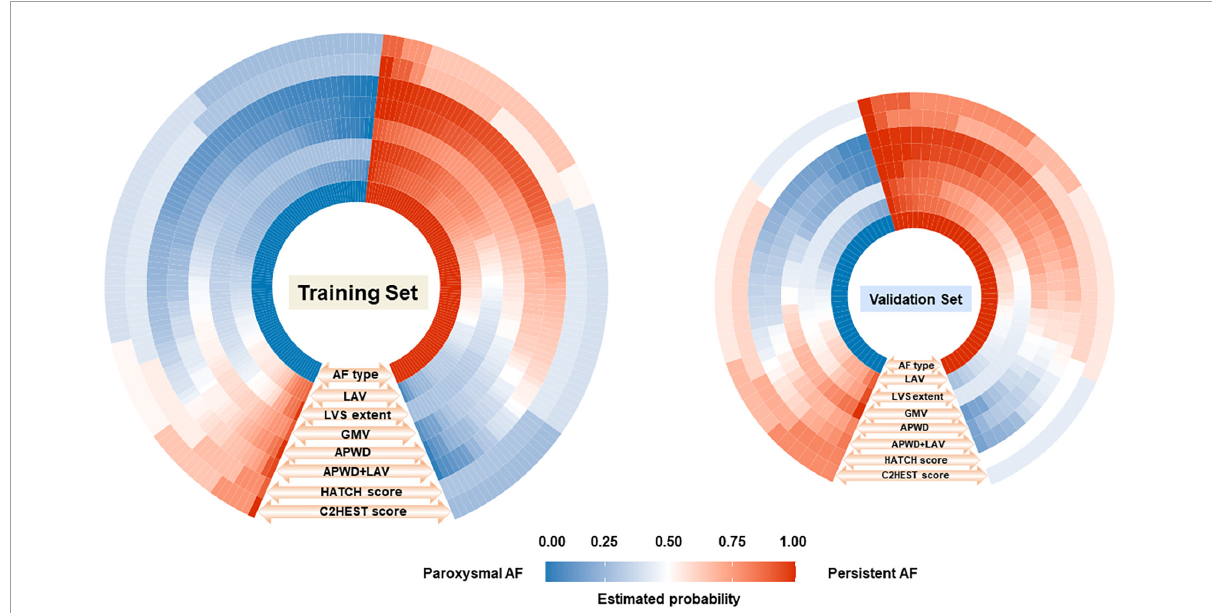
FIGURE5 Comparison between the estimated probability for persistent AF by each model (seven outer layers) and the actual AF types (inner layer, ground truth) in training (left) and validation (right) sets. The figure consists of eight layers, the inner layer represents the ground truth AF types [paroxysmal (blue) or persistent AF (red)] of each individual (small rectangle), and the total number of rectangles in blue and red in the inner layer represents the number of patients in paroxysmal and persistent AF cohort, respectively. As illustrated by the orange arrows and labels at each layer (LAV, LVS extent, GMV, APWD, APWD + LAV, HATCH score, and C2HEST score) in an outward direction, the estimated probability for persistent AF of each individual (small rectangle) by each model was demonstrated in different grades of blue and red, indicating the probability for persistent AF ranging from “0” to “1.0.” The fifth (APWD) and sixth (APWD + LAV) layers which share a higher level of resemblance in color distribution to the inner layer, indicating a better calibration performance. LAV, left atrial volume; LVS, low voltage substrate; GMV, global mean voltage; APWD, duration of the amplified digital